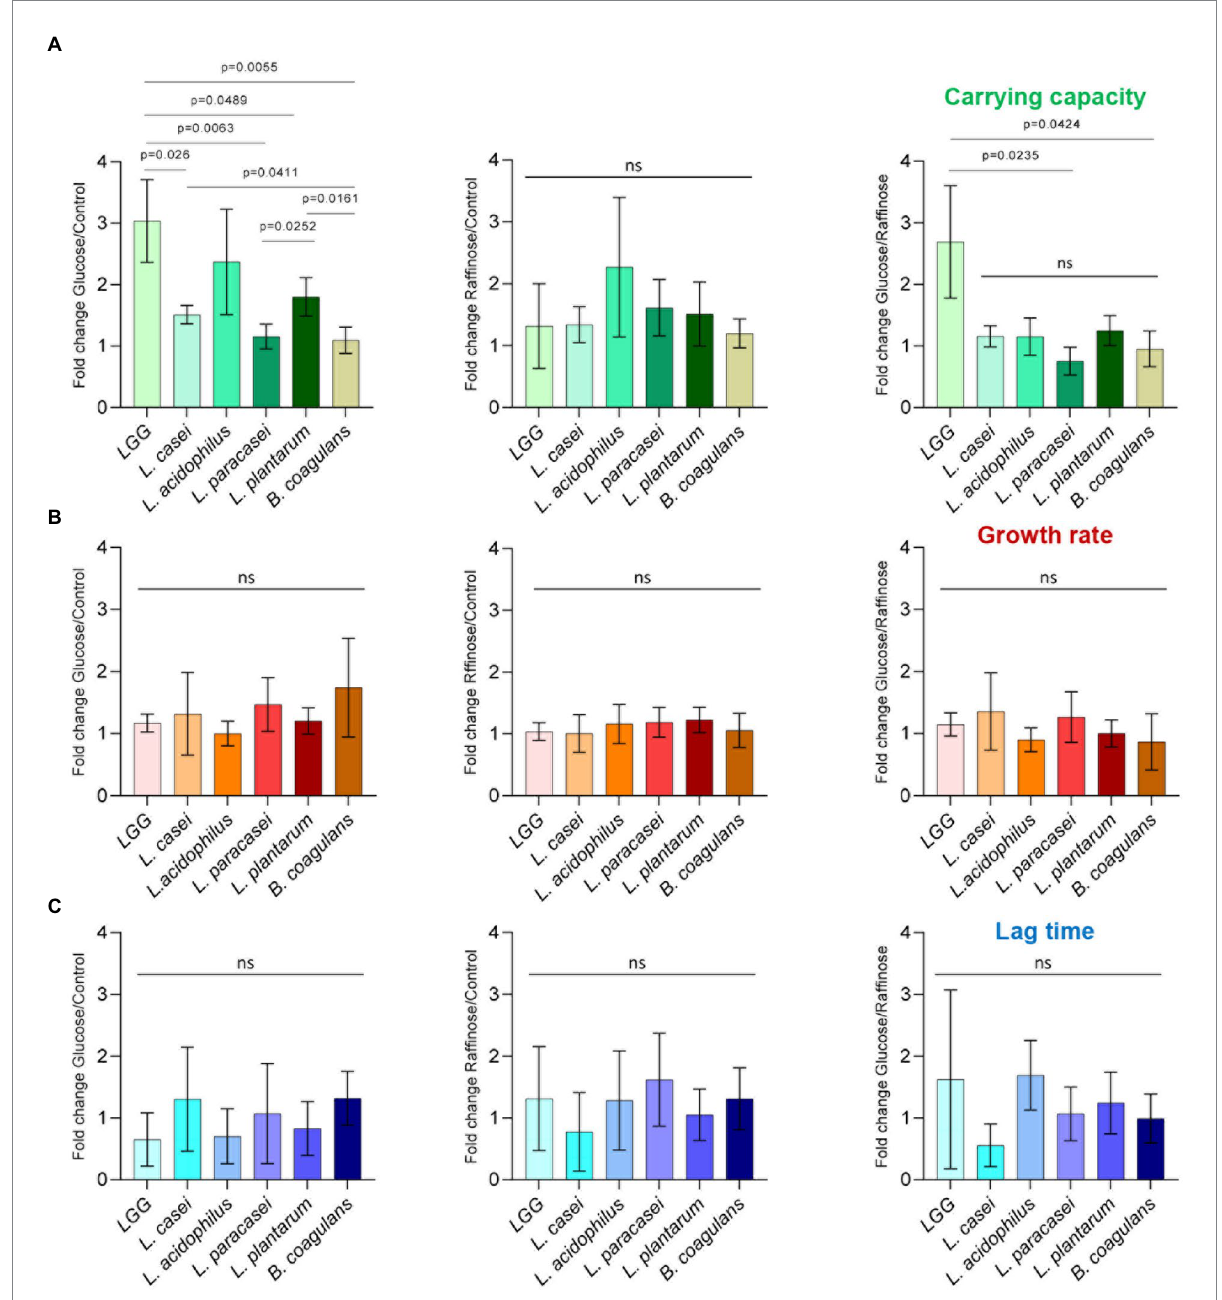
FIGURE 2 Carbon-dependent growth induction is specifically manifested by an altered carrying capacity. Analysis of planktonic growth from the data shown in Figure 1 using GrowthRates 3.0. (A) Fold change, in carrying capacity, (B) growth rate, and (C) lag time of indicated species between glucose/ control, raffinose/control, and glucose/raffinose. Graphs represent mean ± SD from six independent experiments ( n = 24). Statistical analysis was performed using Brown-Forsythe and Welch’s ANOVA with Dunnett’s T3 multiple comparisons test. p < 0.05 was considered statistically